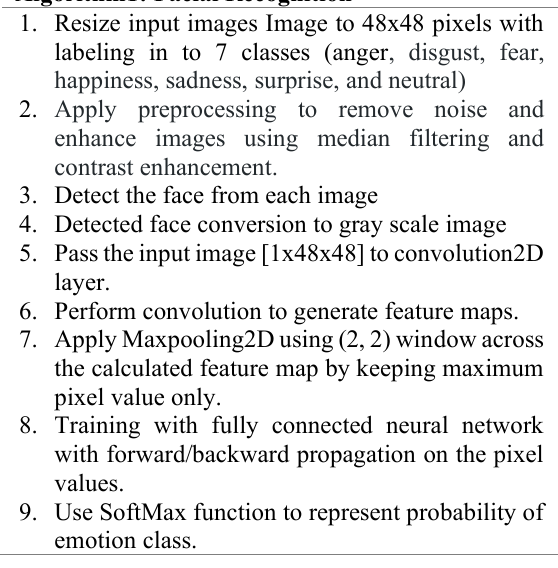
Fig. 2. Generalized Face Recognition System